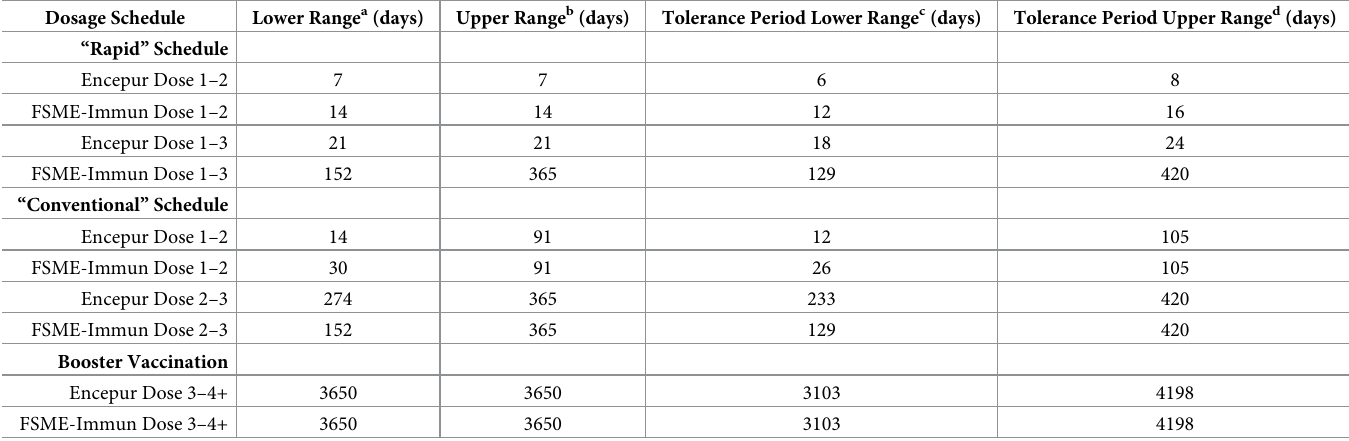
Table 2. TBE vaccine dosage